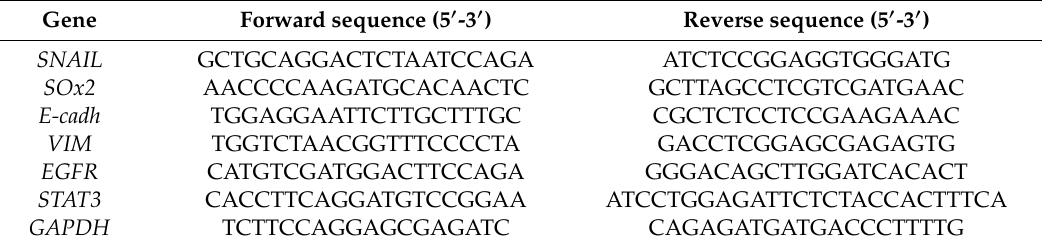
Table 2. Forward and reverse sequences of analyzed